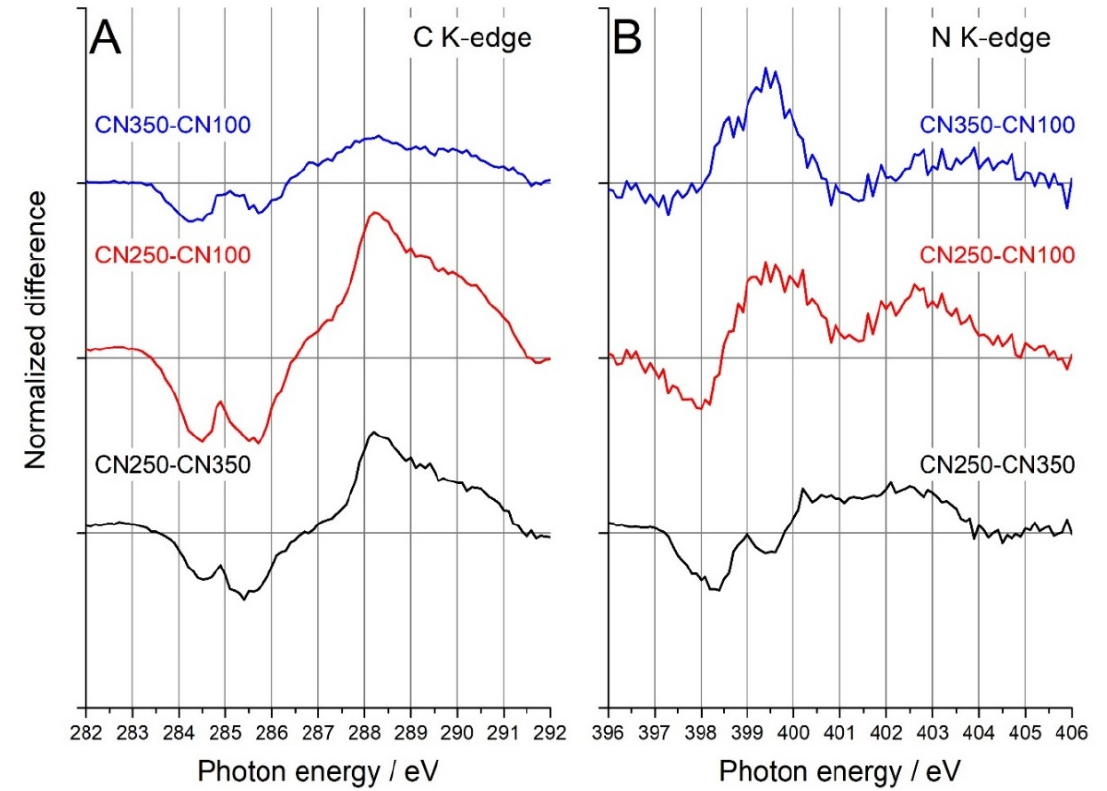
Figure 3. NEXAFS differential analysis at the C K-edge ( A ) and N K-edge ( B ). There were two regions of interest in the NEXAFS difference analysis of C K-edge (Figure 3A): (1) the region between 284 and 286 eV, which has been previously assigned to C 1s → π * in C = C; and (2) the region between 287 and 291 eV, which has been previously assigned to different oxygen functionalities, such as the C 1s → π * of C = O (286.5 eV) and COOH (288.3 eV), and the C 1s → σ * of C–OH (289.3 eV). Minor differences were found be- tween CN350 and CN100. A considerable decrease was measured in the 284–286 eV region for CN250 when compared to CN100 and CN350. The decrease in this area suggested that the aromaticity was lost, which was further confirmed by an increase in the 287–291 eV region, specific for oxygen functionalities (vide supra). The reader should bear in mind that the region between 287 and 291 eV is also specific for different nitrogen functionali- ties [37,38]. The N/C concentration followed the trend CN250 > CN350 > CN100, which can also be inferred from Figure